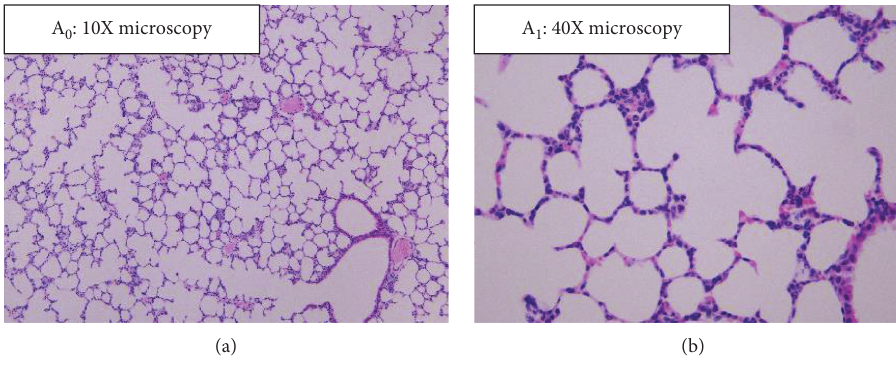
Figure 5: HE-stained lung tissue cells (control